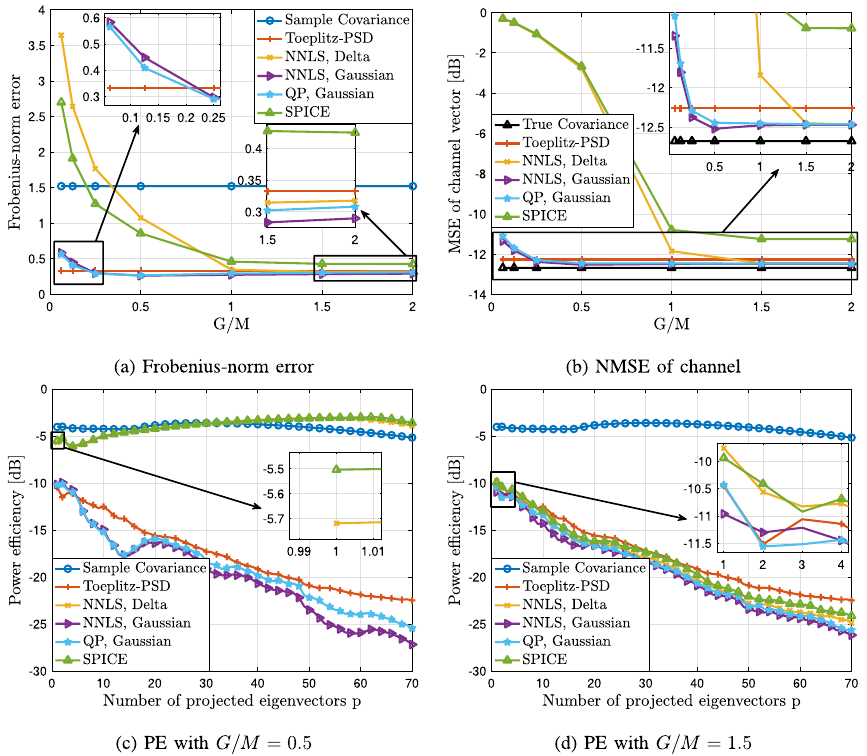
Fig. 8 Comparison with Dirac delta and Gaussian dictionaries with N / M = 0.125 under various G / M for scenario